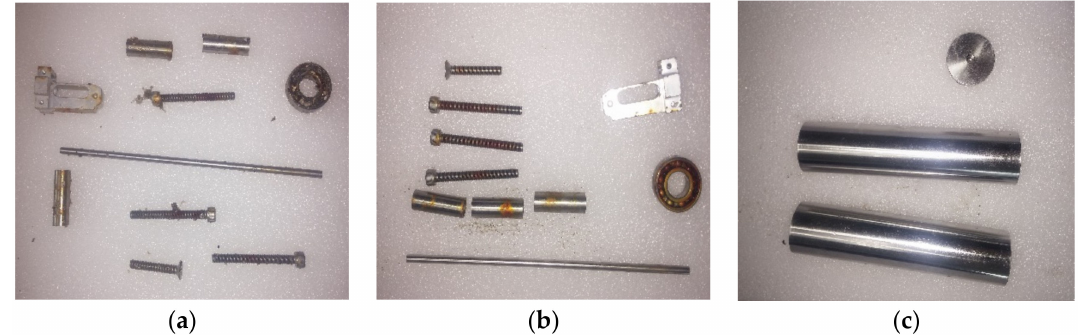
Figure 3. Result for the sea water test of: ( a ) an anodized aluminum cover; ( b ) a stainless steel (SUS304); and ( c ) a stainless steel